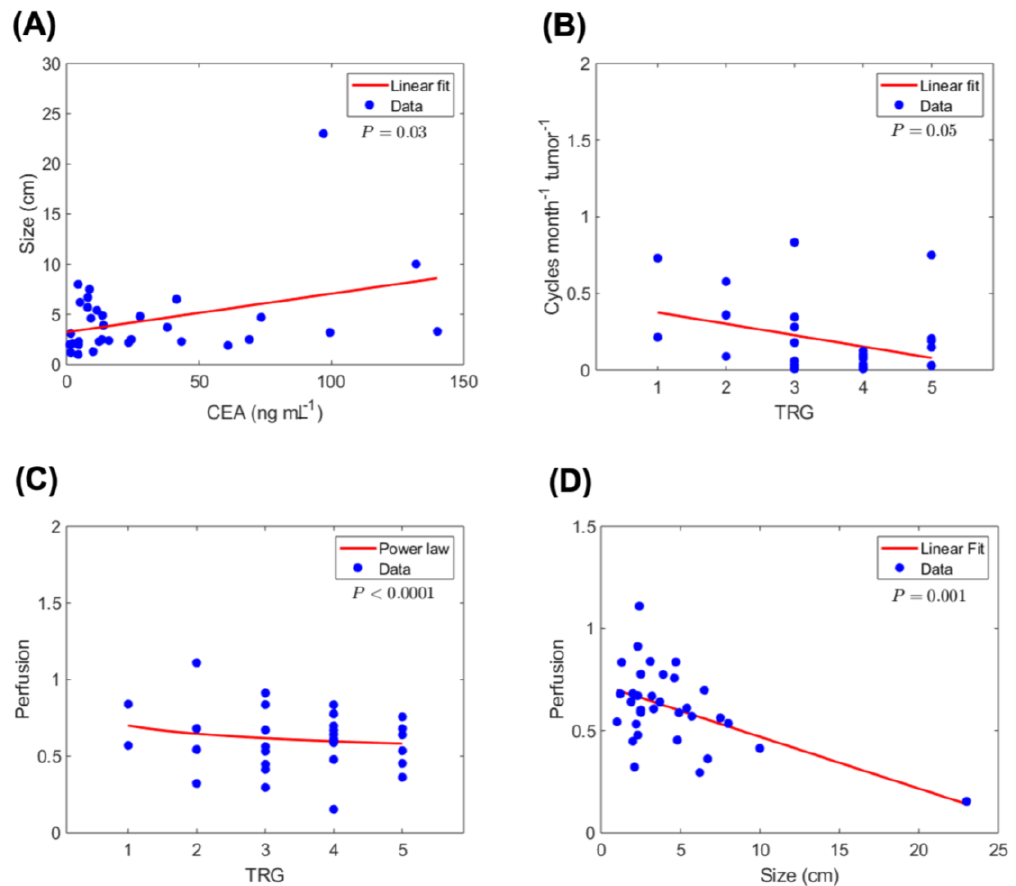
Figure 2. Correlation analysis of tumor, treatment and outcomes variables. Statistically significant correlations are observed between tumor and treatment-related variables and pathological TRG ( n = 33 patients). ( A ) Correlation of serum CEA with tumor size (largest dimension). ( B ) Correlation of therapy cycle rate per unit tumor burden (i.e., number of treatment cycles per month per unit CEA) with TRG. ( C ) Correlation between tumor perfusion and TRG. This measurement is a surrogate for the blood volume fraction (BVF) parameter in the model. ( D ) Tumor perfusion correlates negatively with tumor size, indicating reduced perfusion in larger lesions.